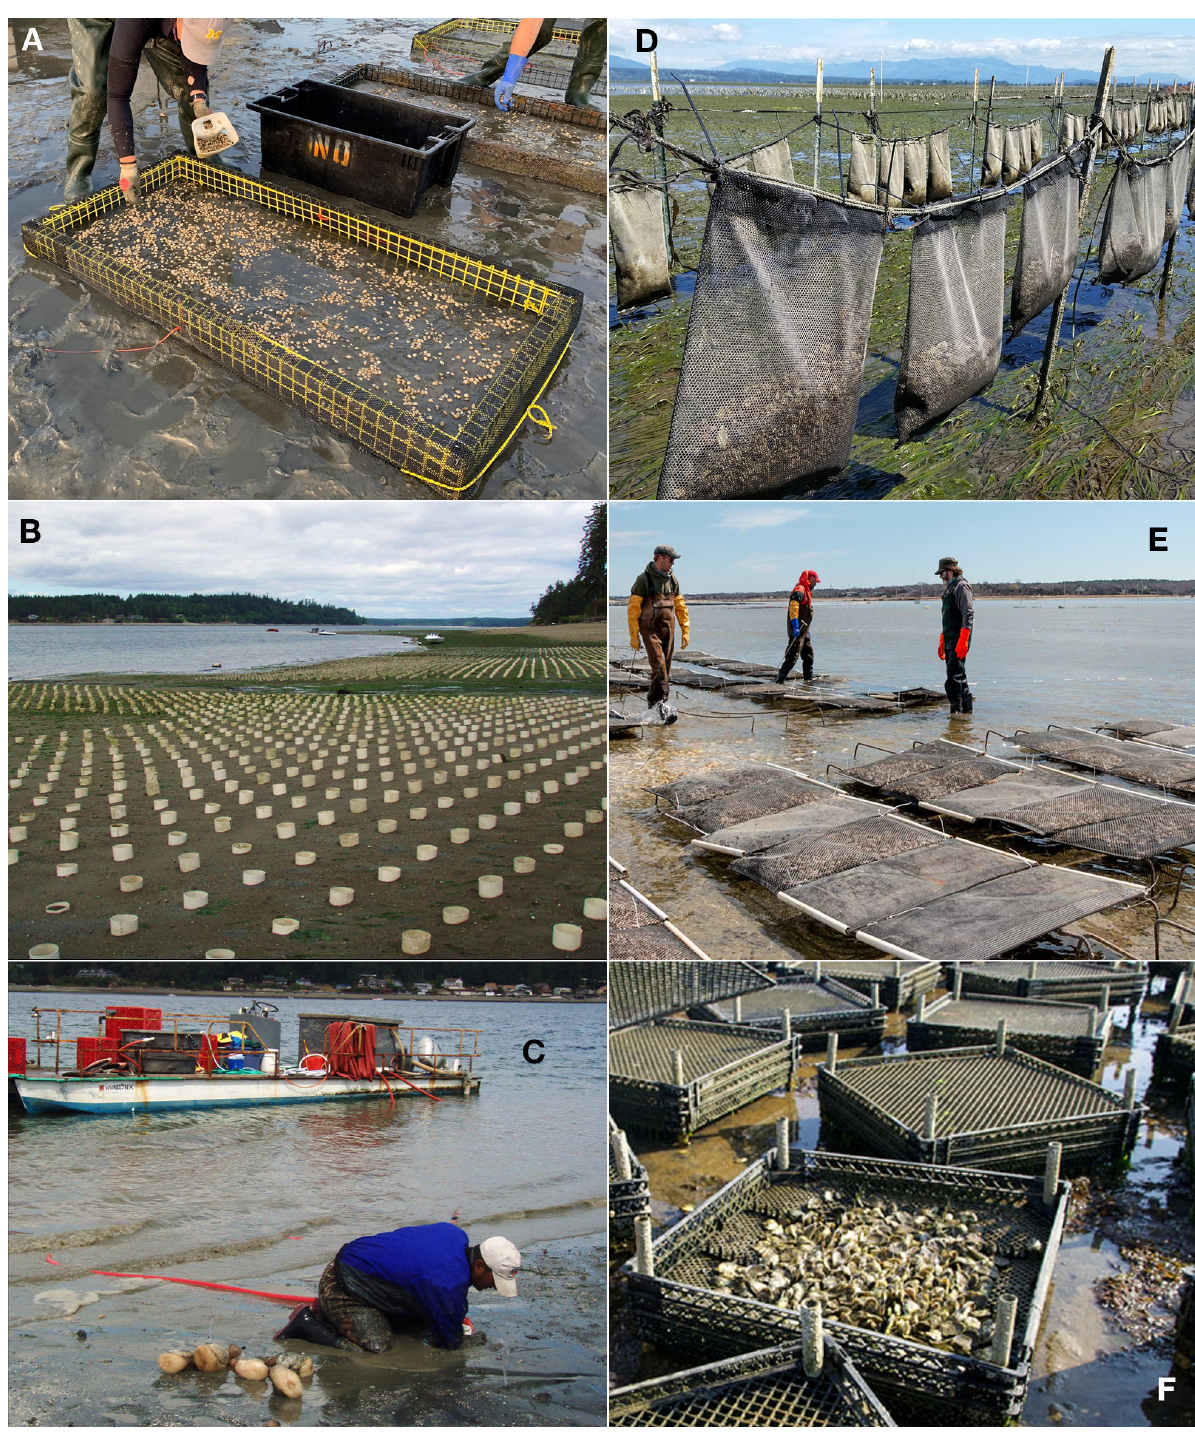
Fig. 2. Examples of intertidal shellfish aquaculture. (A) On-bottom clam farm seeded with spat (photo: by Pangea Shellfish Company). (B,C) On-bottom geoduck Panopea generosa farm and subsequent harvesting using a high-pressured water jet powered by a support vessel (photos: Jeff Cornwell). (D) Hanging-bag oyster farm (photo: Penn Cove Shell - fish). (E) Rack-and-bag oyster farm (photo: Pangea Shellfish Company). (F) Tray culture oyster farm (photo: Pangea Shellfish